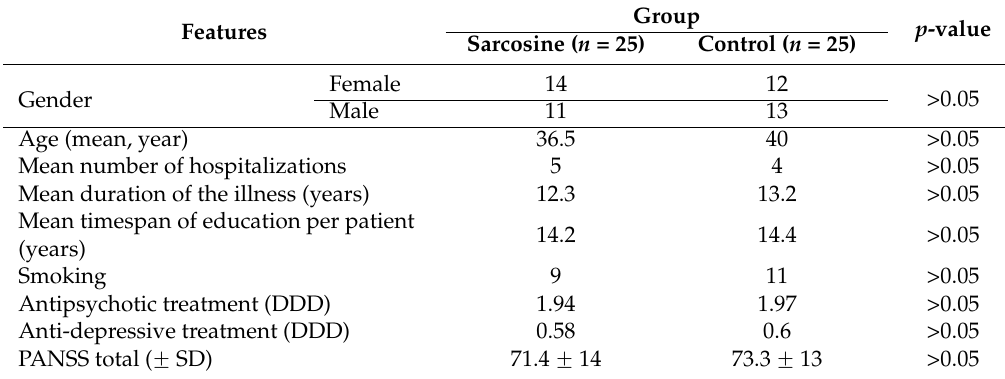
Table 1. Characteristics of